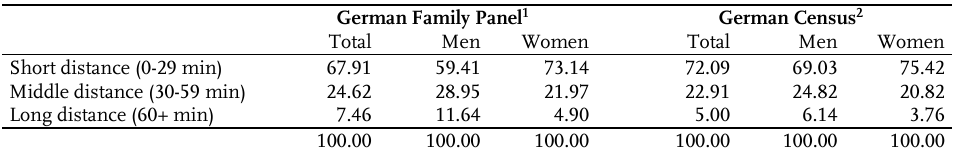
Table 1 : Commuting distance (measured in minutes) (in %) German Family Panel 1 German Census 2 Total Men Short distance (0-29 min)